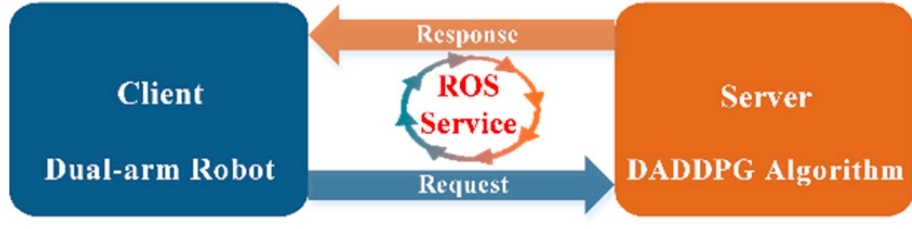
Figure 7. The control architecture. The agent of the deep reinforcement learning algorithm is a server and sends a response to the client. The dual ‐ arm robot is a client and requires service from the server.